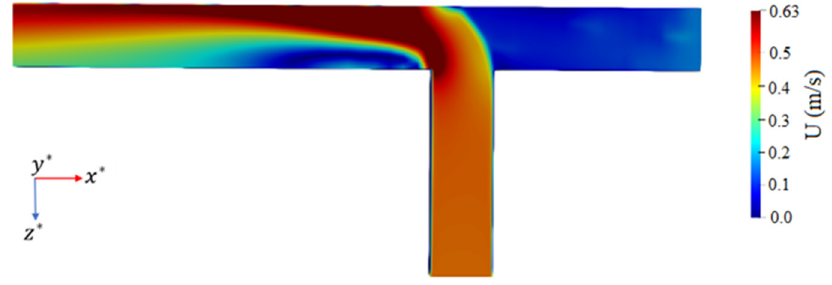
Figure 15. The distribution of water surface velocity (Standard k- ε ).